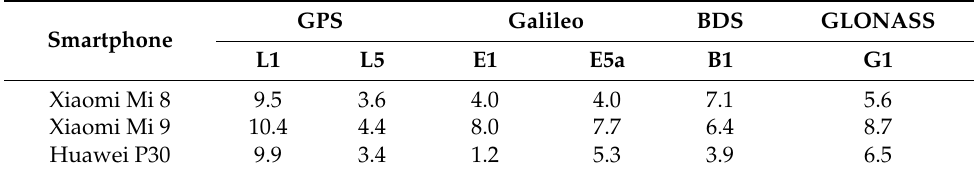
Table 1. Number of tracked satellites per frequency bands given as an average over the data collection